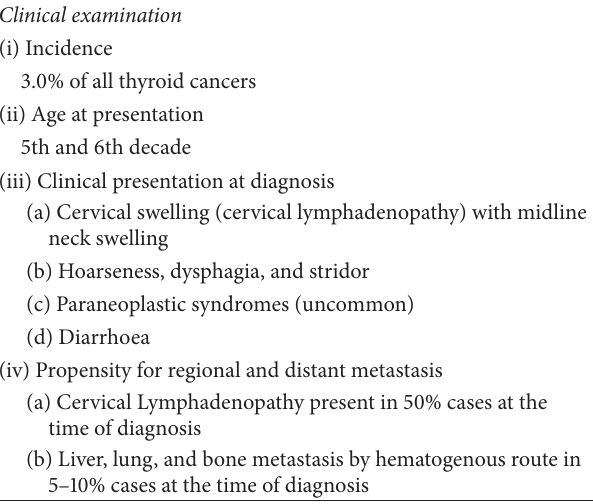
Table 1: Medullary carcinoma thyroid: an